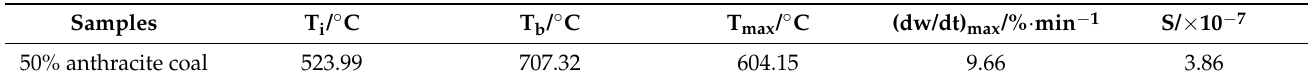
Table 2. Combustion parameters for anthracite and bituminous coal after uniform mixing at 1:1.